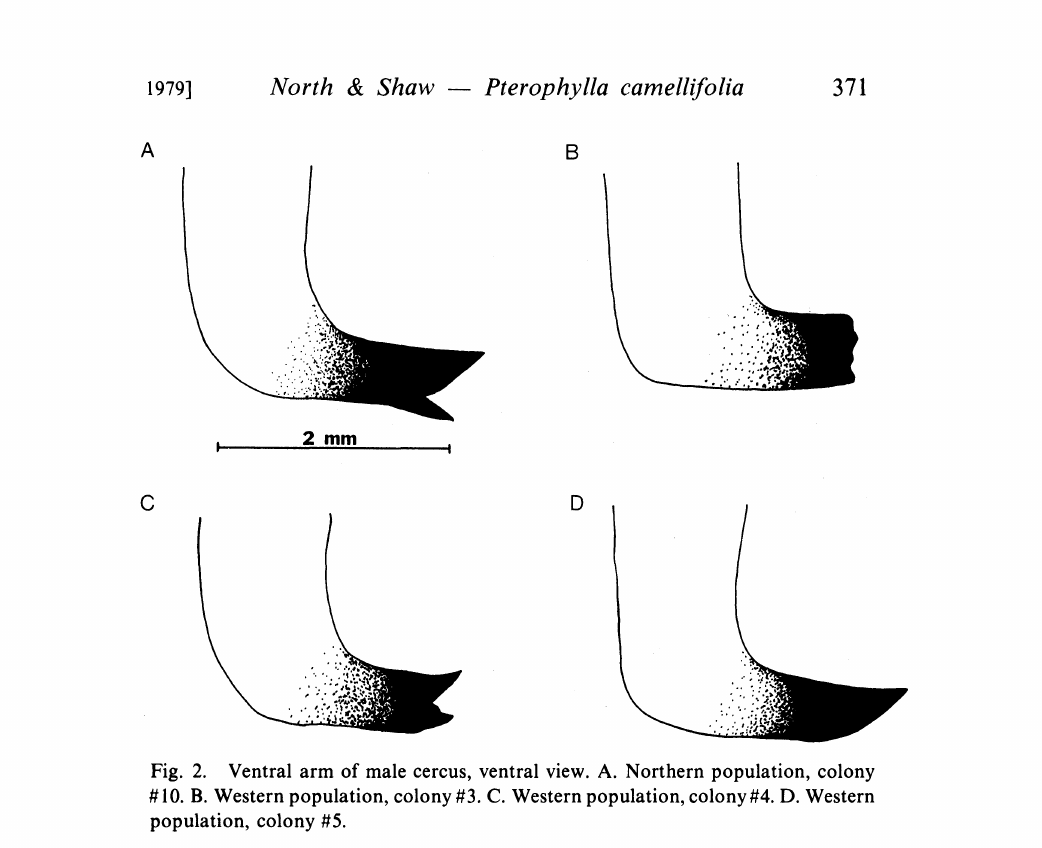
Fig. 2. Ventral arm of male cereus, ventral view. A. Northern population, colony # 10. B. Western population, colony #3. C. Western population, colony#4. D. Western population, colony